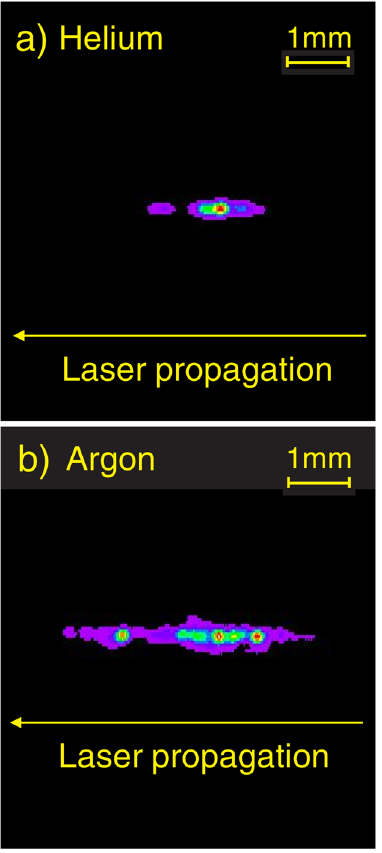
5. (Color) Results of a 90 (cid:5) Thomson side scattering at the wavelength of the interaction beam for He and Ar: (a) in He at neutral gas density of 2 : 2 (cid:3) 10 19 cm (cid:4) 3 and (b) in Ar at neutral gas density of 5 : 0 (cid:3) 10 18 cm (cid:4) 3 ,